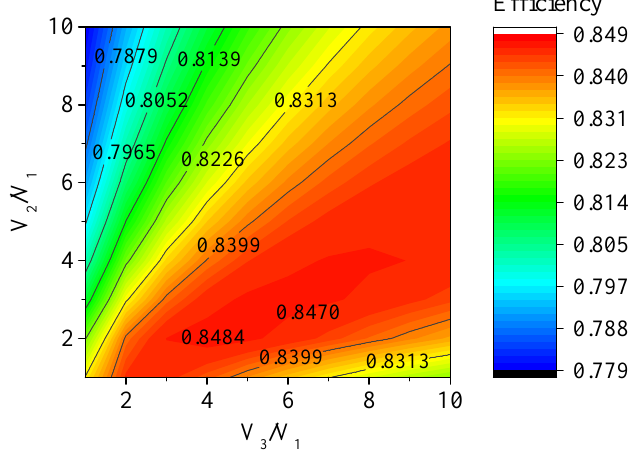
Figure 9. The simulated efficiency η as a function of the ratio of the input